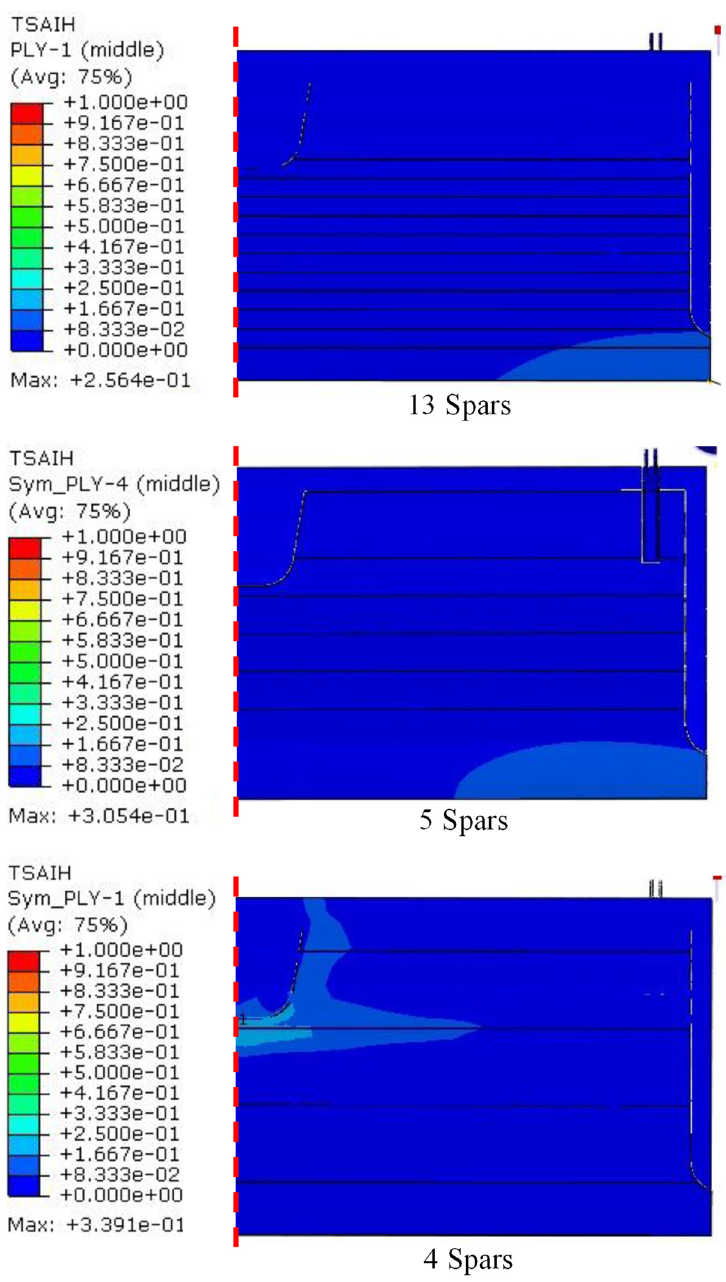
Figure 6. The Tsai–Hill failure index for multi-spar configurations (half-model presented). The Tsai–Hill failure index for 13 co-cured spars was 0.26, and the maximum deflection was 3.9 mm. This configuration made the spoiler stiffer than the baseline. The multi-spar performances decreased by about 15–30% as the number of spars was reduced to 5 co-cured spars (0.3) and 4 co-cured spars (0.34), respectively. On the other hand, the maximum deflection for the 5 co-cured spars was 4.2 mm and 4.5 mm for the 4-co-cured-spar model. The deflection also did not vary much for the different multi-spar